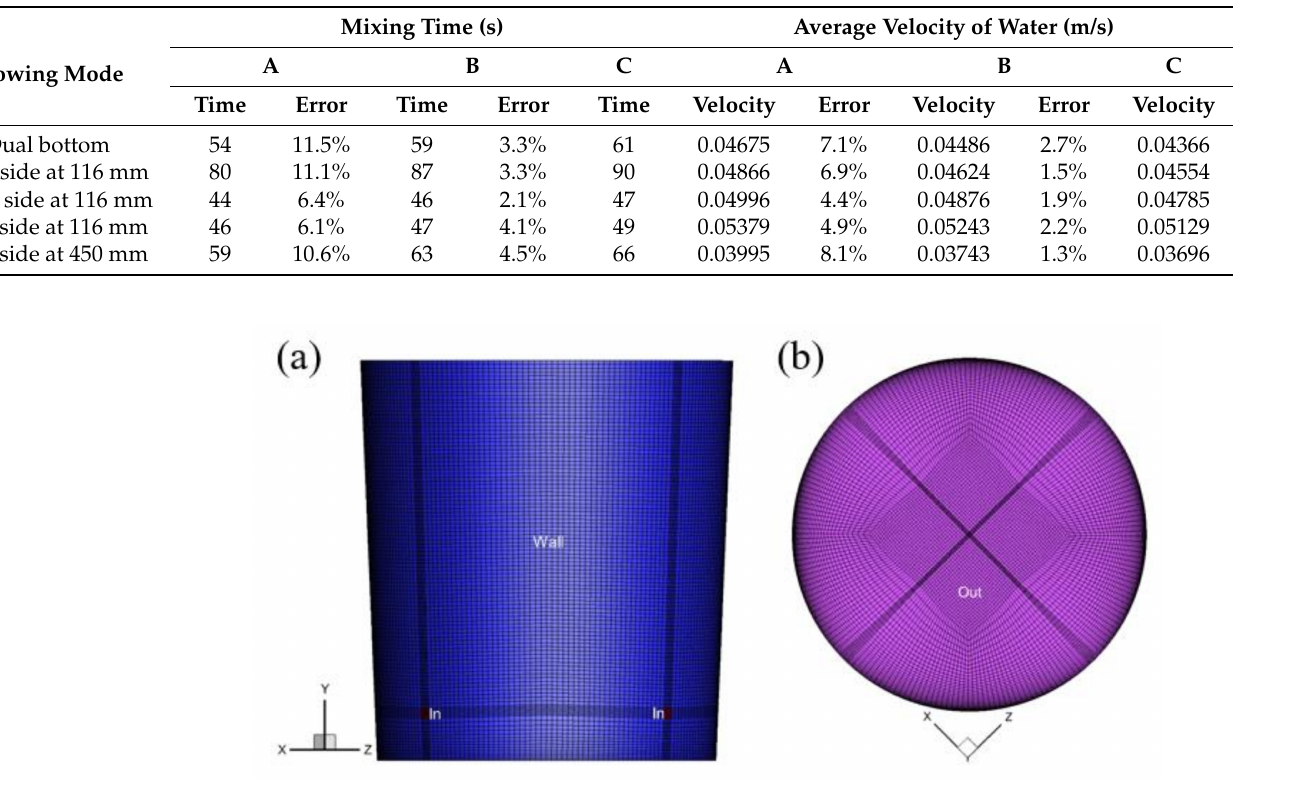
Figure 5. Mesh system of the model ladle: ( a ) front view; ( b ) top view. Table 5. Mesh